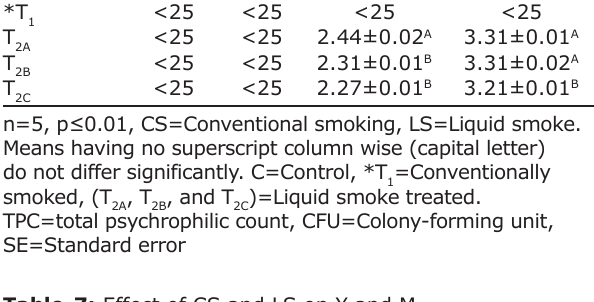
Table-7: Effect of CS and LS on Y and M count (log CFU/g) of pork sausage at different storage periods (mean±SE).